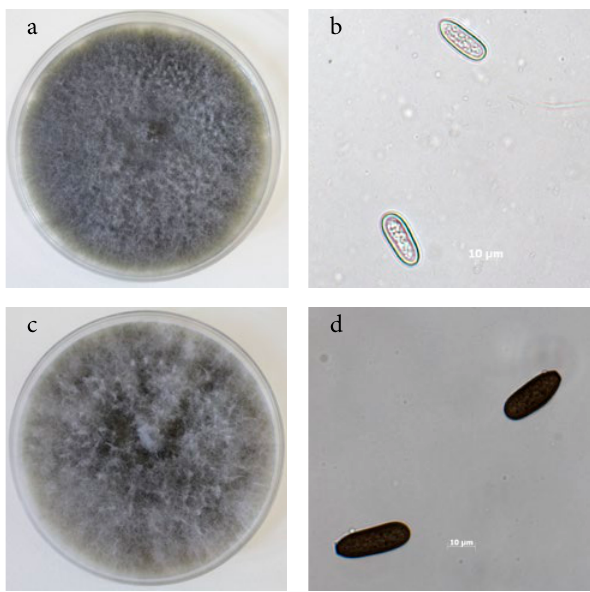
Figure 2. Colonies and conidia on PDA after 7 d at 25°C: (a, b) Diplodia africana; (c, d) Diplodia seriata .